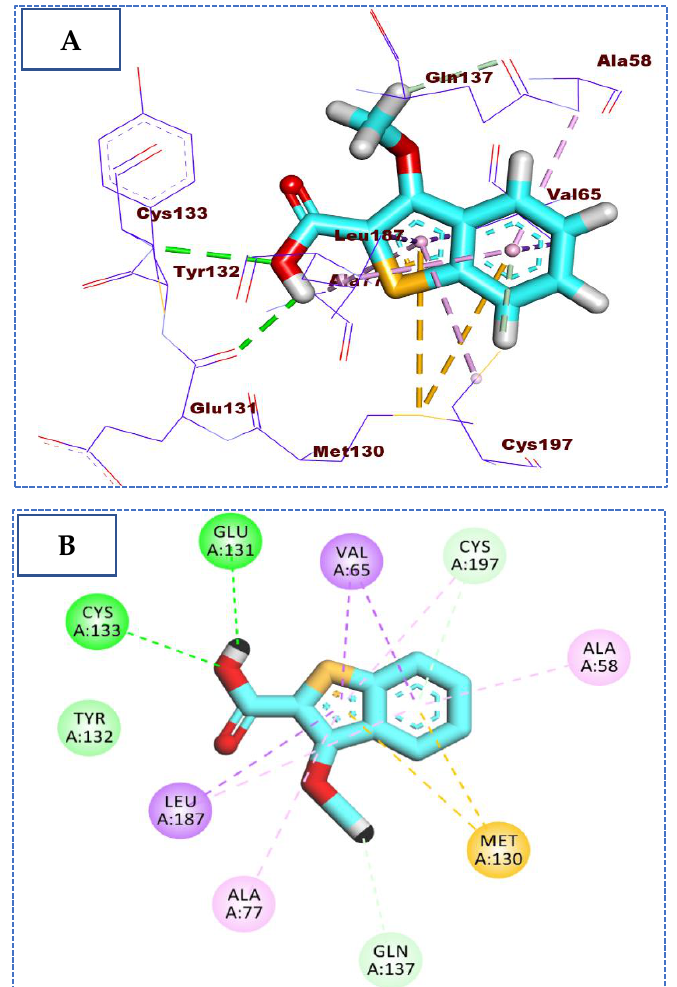
Figure 5. ( A ) The 3D and ( B ) 2D binding of 26 in the active site of BMP-2-inducible kinase (hydrogen bonds = green dashed lines, electrostatic interactions = orange dashed lines, pi-pi interactions = purple dashed lines, and pi-alkyl interactions = light pink dashed lines).